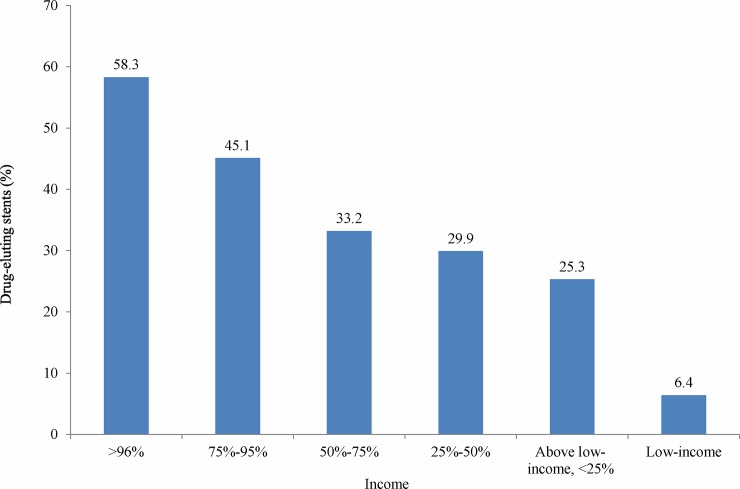
Proportion of patients received DES, by income.